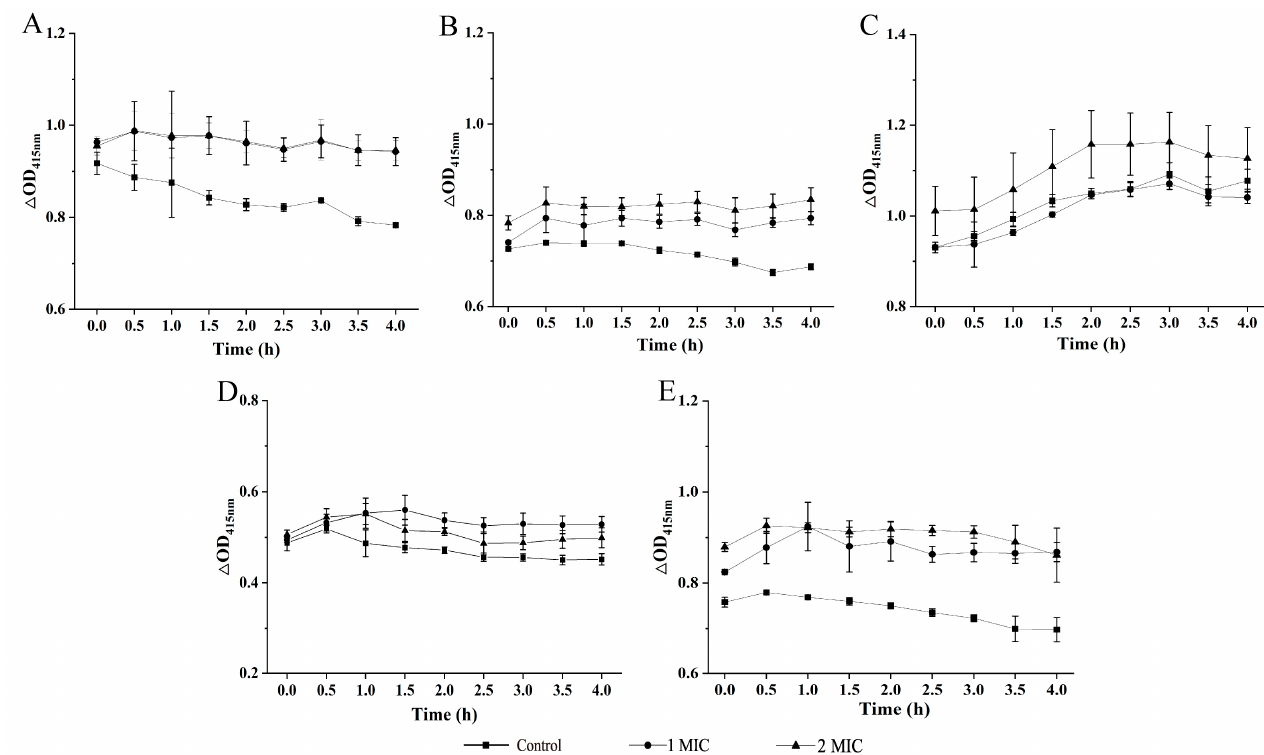
Figure 3. The effects of the GMPE on bacterial CIM permeability. ( A – E ) S. aureus ATCC8095, A. hydrophila, E. sakazakii CMCC45401, V. metschnikovii ATCC700040, and V. parahaemolyticus ATCC17802, respectively.